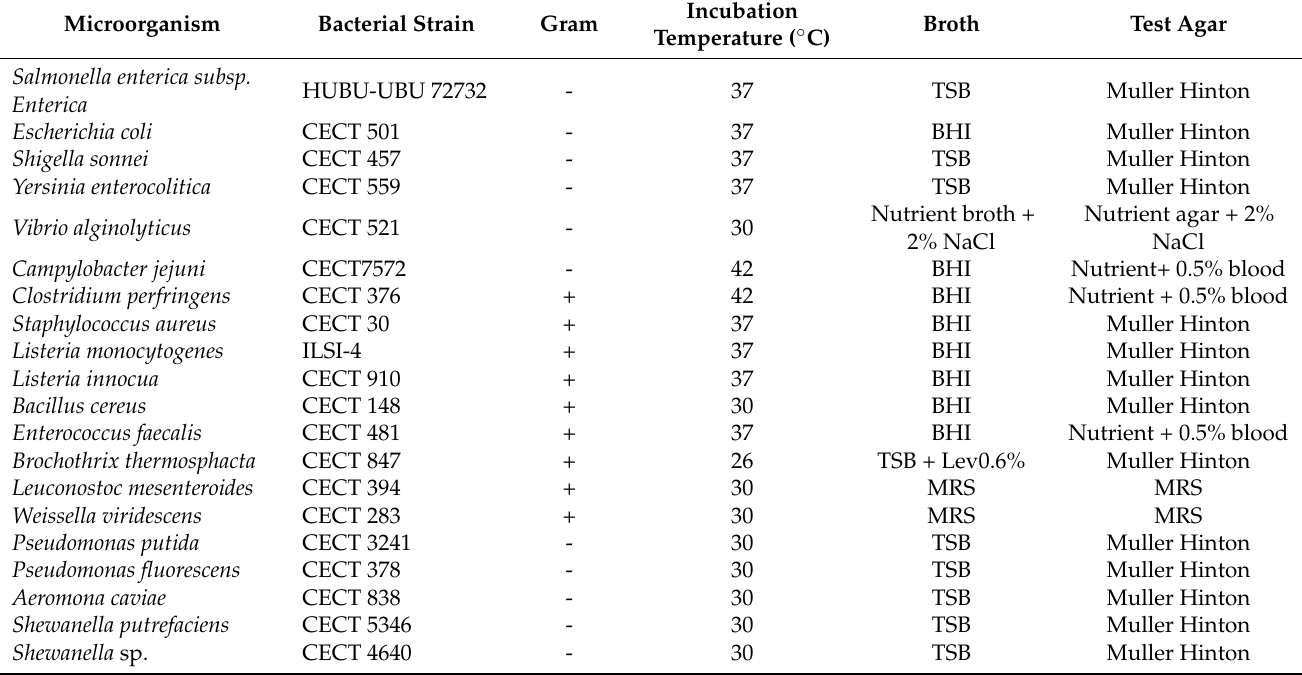
Table 1. Bacterial strains selected for this study and their culture